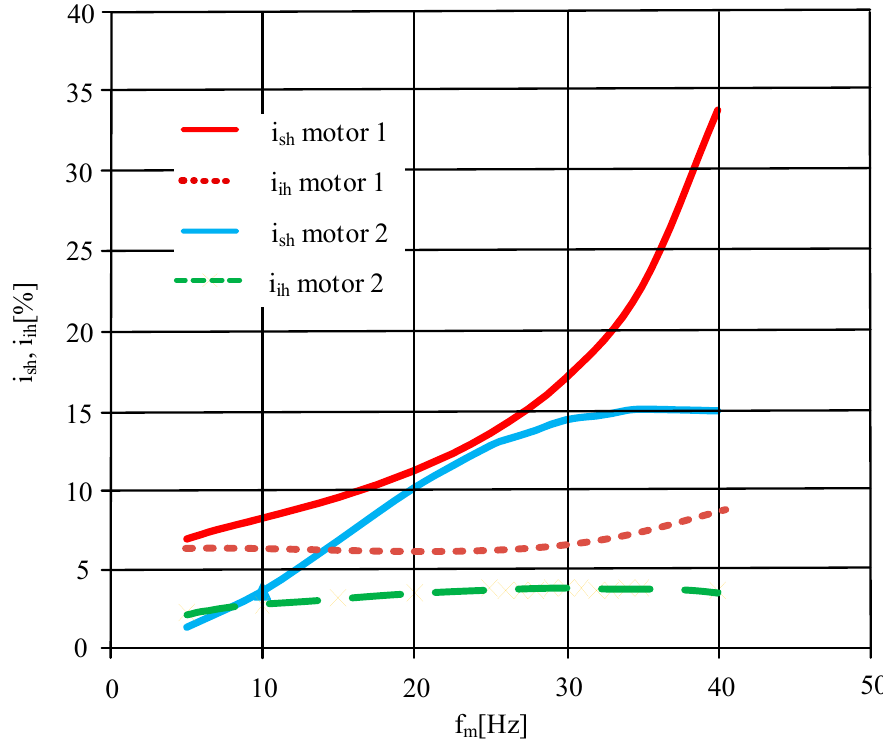
Figure 14. Current subharmonics and interharmonics versus the frequency of voltage fluctuations for the phase modulation ( φ sh = 0 ◦ , φ ih = 180 ◦ ) and the work with a constant rotational speed. The frequency components are related to the rated current.